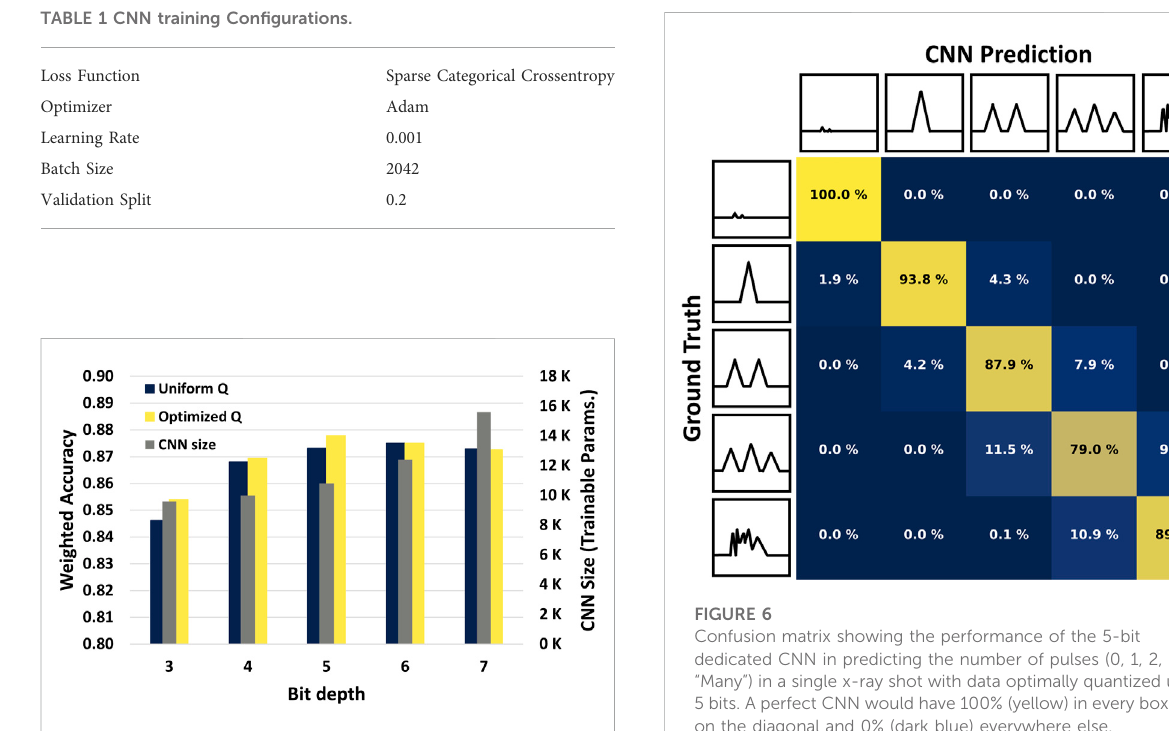
FIGURE 5 CNN weighted accuracy and size. Grey bars read on the right axisandtheblueandyellowbarsontheleftaxis.The modelshows higher accuracy with 5-bit depth over 7-bit depth while requiring fewer model parameters.